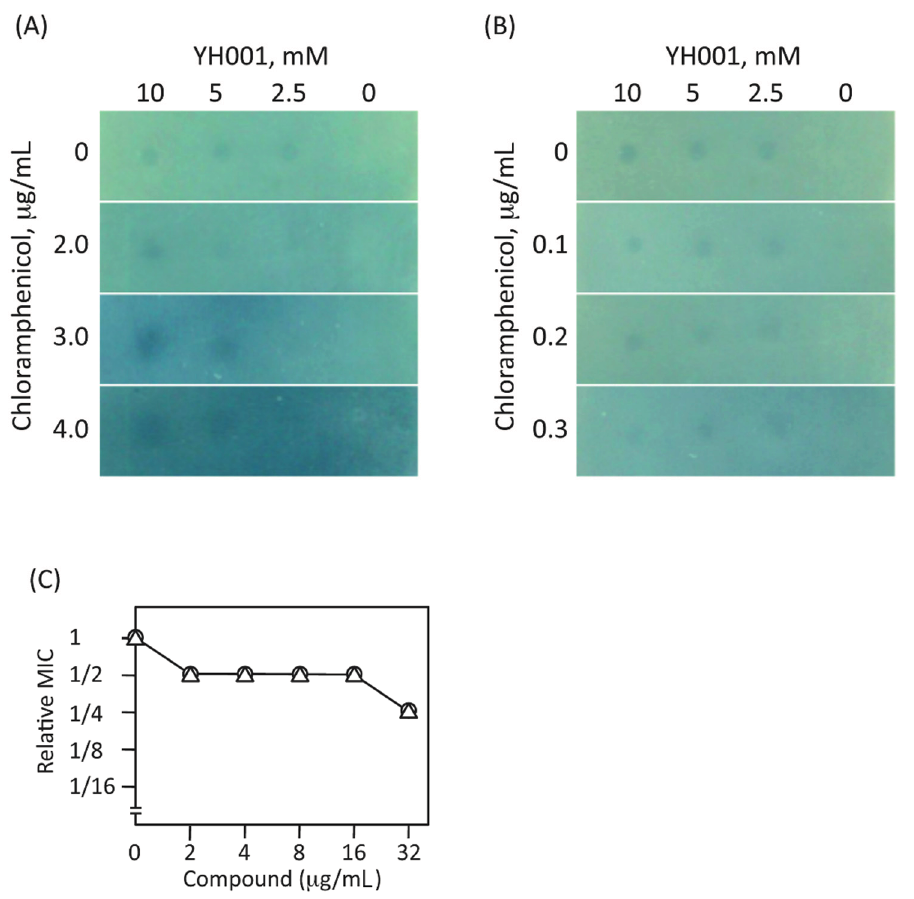
Figure 7. Effect of YH001 on the growth of E. coli strains in the presence of sub-lethal concentrations of chloramphenicol and synergistic effects of YH001 with antibiotics. ( A ) Effect of YH001 on the wild-type E. coli strain BW25113; ( B ) Effect of YH001 on acrB -deficient mutant E. coli JW0451 ( Δ acrB ). Agar plates were prepared mixing with